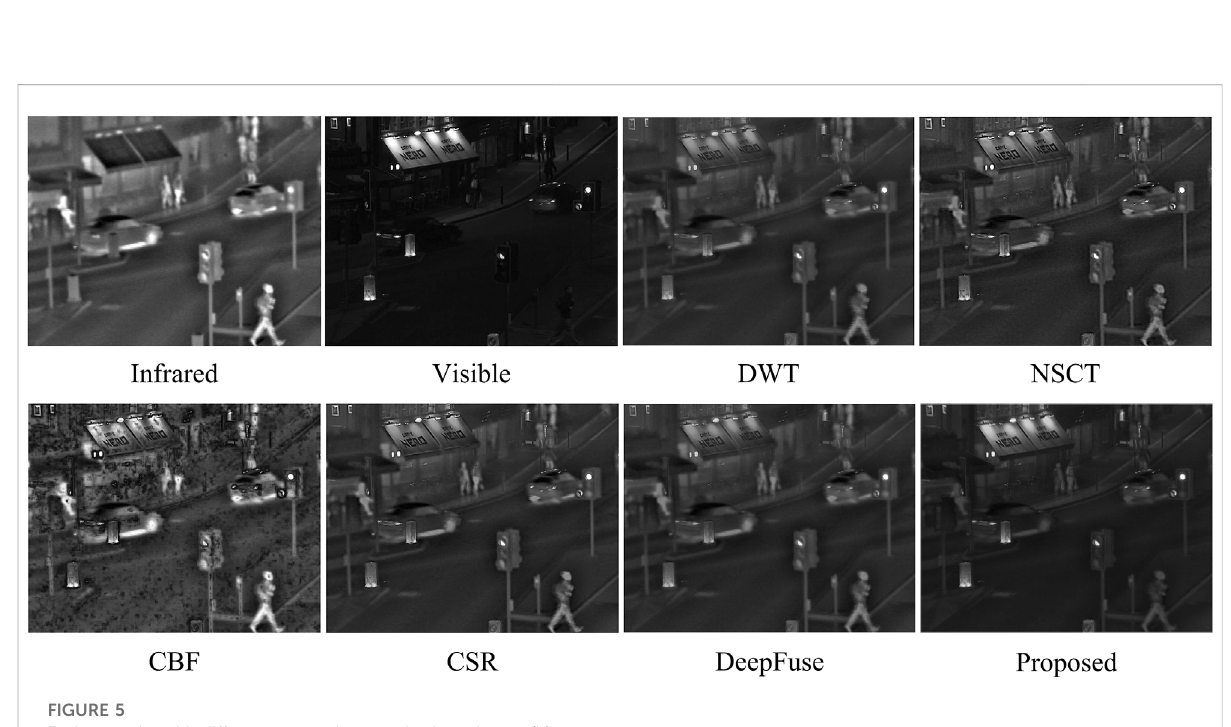
FIGURE 5 Fusion results with different comparison methods on image